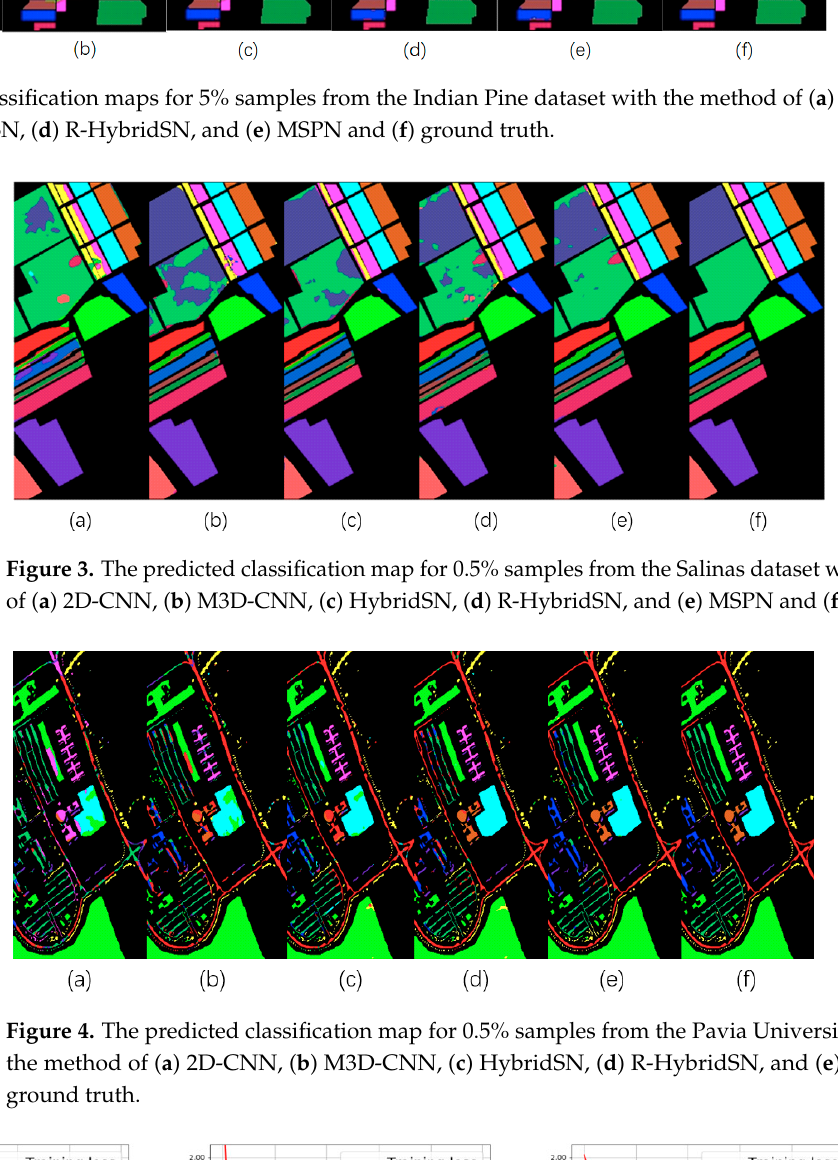
Figure 4. The predicted classification map for 0.5% samples from the Pavia University dataset with the method of ( a ) 2D-CNN, ( b ) M3D-CNN, ( c ) HybridSN, ( d ) R-HybridSN, and ( e ) MSPN and ( f ) ground truth. Table 2. Accuracy comparison of different methods for 5% samples of Indian Pine.